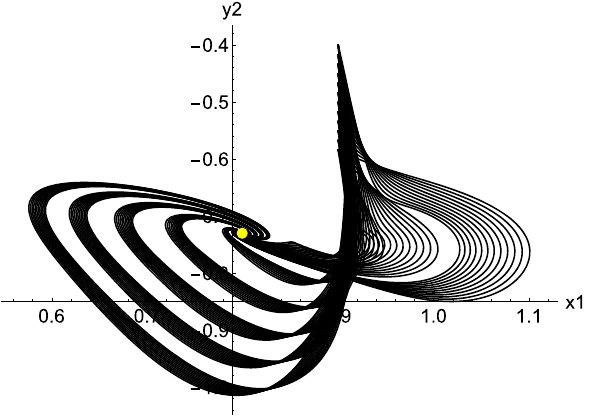
Fig. 8 The evolution towards the B critical point in the x 1 Oy 2 plane for various initial conditions